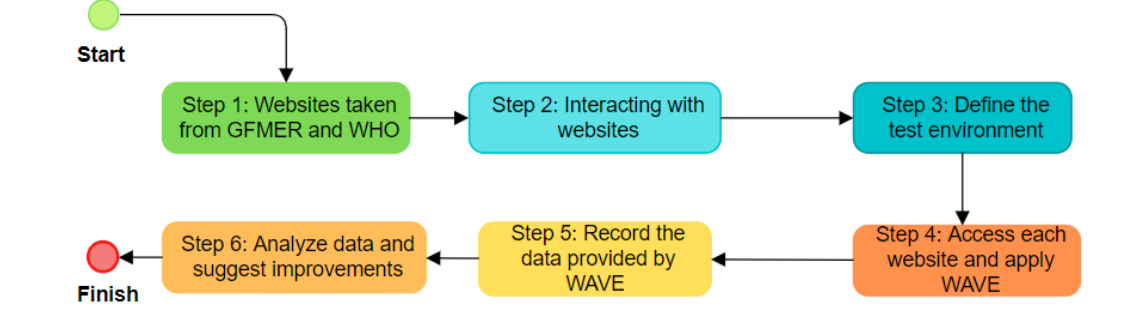
Figure 1. Automatic review method applied to the websites. Table 3. Sample of the first 40 websites